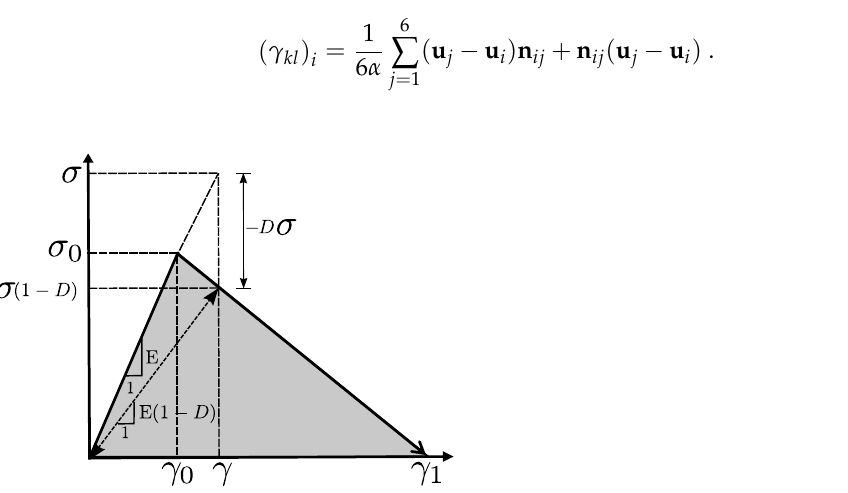
Figure 6. Schematic representation of the bilinear constitutive law adopted to each interaction ij . Thus, the strain tensor which defines each interaction ij is approximated as the mean value between i and j node